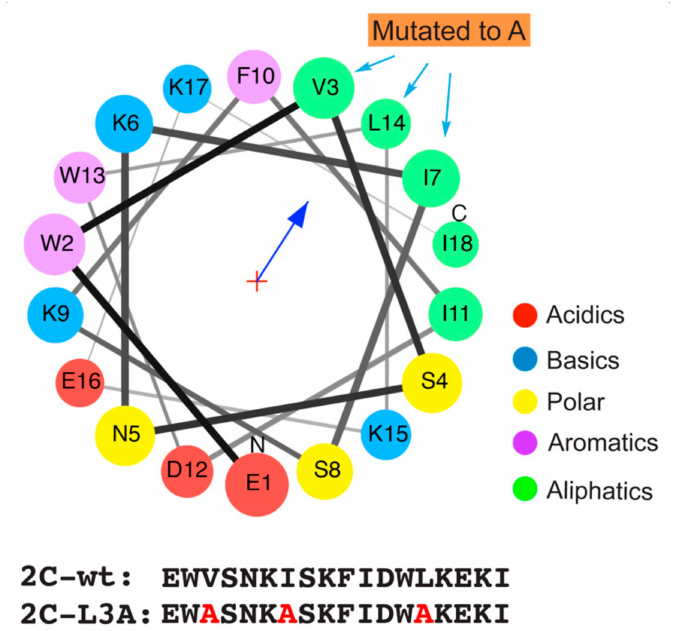
Figure 1. Helical wheel projection of the α -helix from poliovirus 2C protein in the N-terminal region. 2C-wt: amino acids 19–36 of poliovirus 2C; 2C-L3A: Amino acids at position 3, 7, and 14 were mutated to alanine. Red, acidic amino acid; blue, basic amino acid; yellow, polar amino acid; purple, aromatic amino acid; green, aliphatic amino